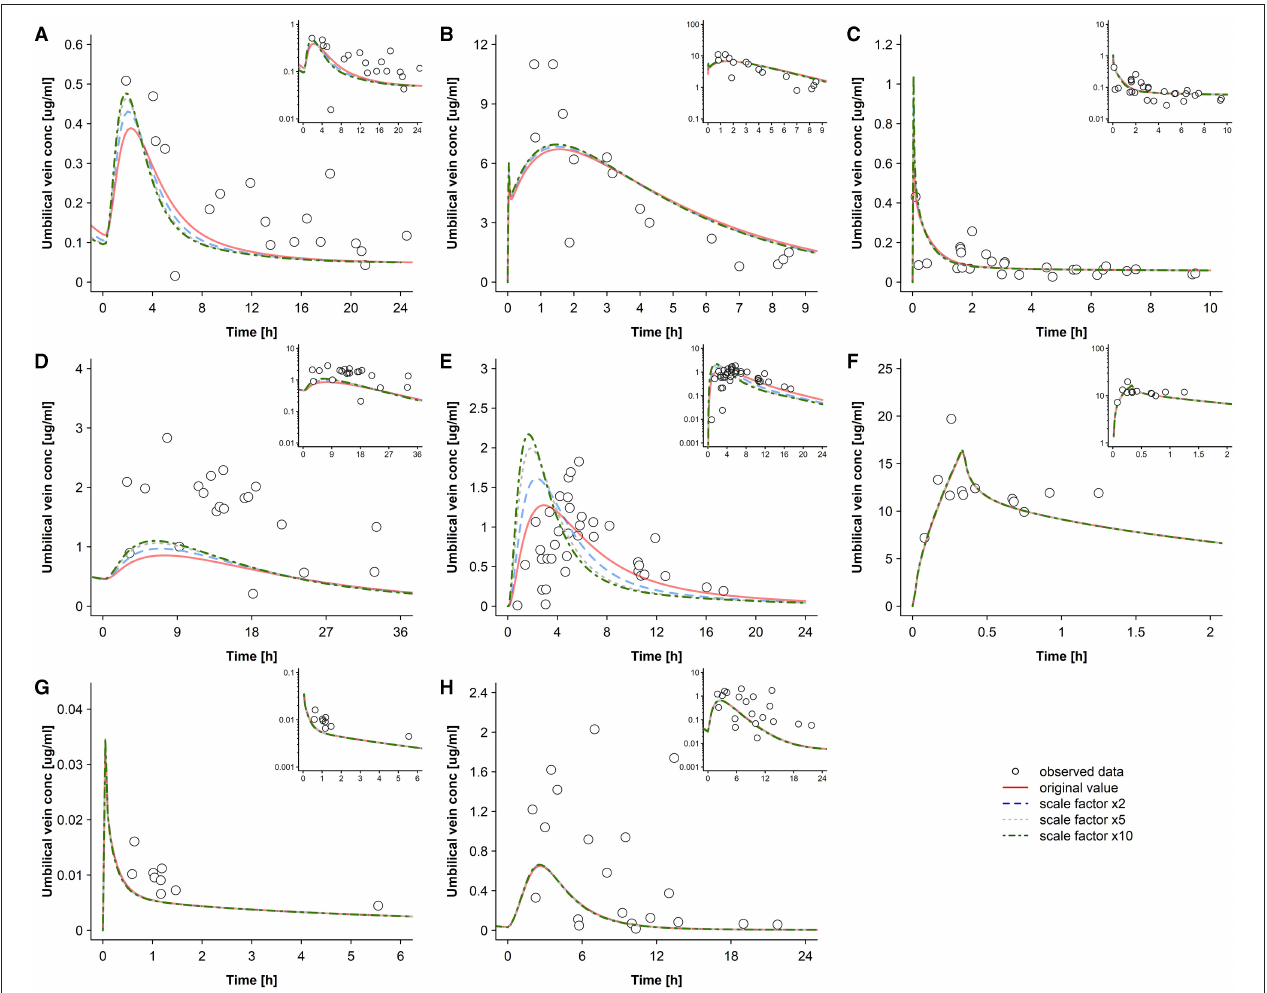
FIGURE 6 | Sensitivity analysis for the transfer clearance across the apical trophoblast membrane where both influx and efflux clearance are equally varied. Concentration-time profiles in the umbilical vein plasma for acyclovir (A) , cefuroxime (B) , diazepam (C) , dolutegravir (D) , emtricitabine (E) , metronidazole (F) , ondansetron (G) , and raltegravir (H) at delivery in the third trimester. Semi-log scaled figures are shown as inset plot in the top-right corner of each panel. Circles represent individual observed data and the lines represents the predicted geomean concentrations with different transfer clearances across the apical trophoblast membrane (both influx and efflux transfer clearance are equally altered). Observed data for acyclovir, cefuroxime, diazepam, dolutegravir, emtricitabine, metronidazole, ondansetron, and raltegravir were taken from Liu et al. ( 18), Leung et al. (39), Hirt et al. (40), Philipson and Stiernstedt (41), De Leeuw et al. (42), Elkomy et al. (43), Visser and Hund (44), Moore and McBride (45), Ridd et al. (46), and Mandelli et al. (47), respectively. conc,